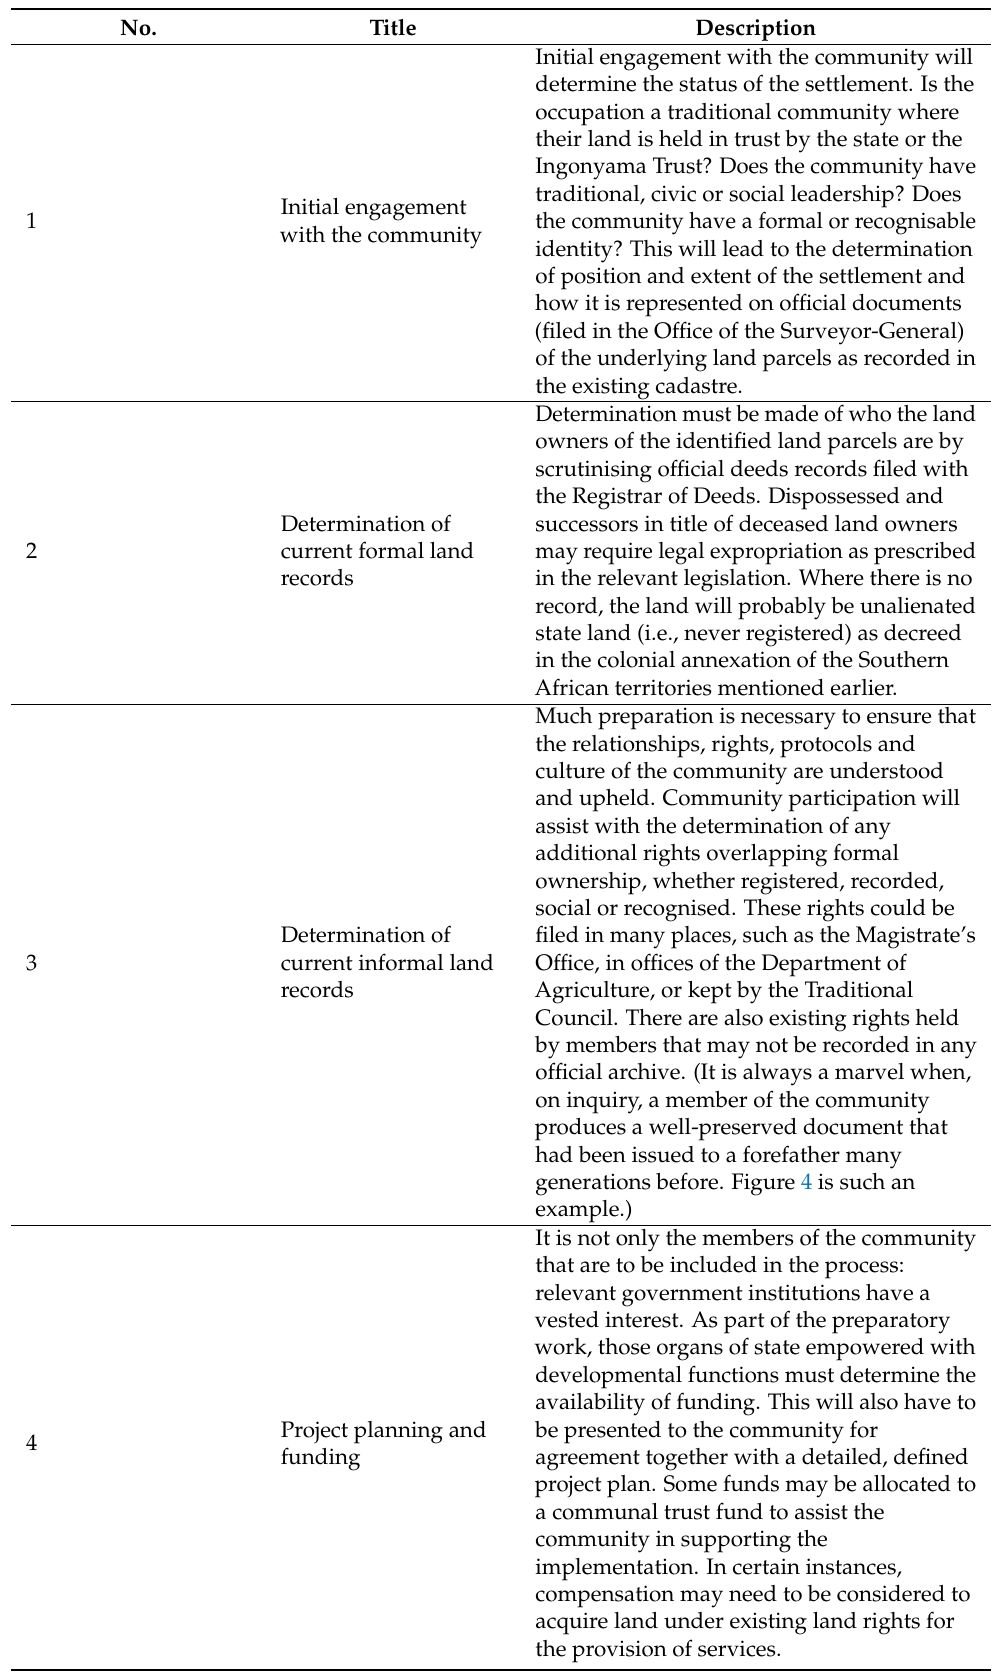
Table 1. A proposed institutional methodology of eight key